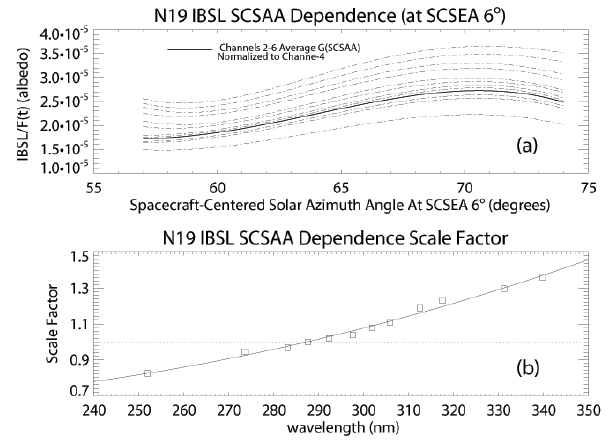
Fig. 14. (a) Dashed curves in the top panel are for 12 channels of fit- ted G (SCSAA) functions, which monotonically increases as wave- length increases. Only channels 2–6 are averaged for the wavelength independent factor g 0 (SCSAA) because of the earth shine contam- ination at the long wavelengths and low signal at 252nm. (b) The scale factors in the bottom panel, C(λ) , result from the least square between G (SCSAA) and g 0 (SCSAA) × C(λ)